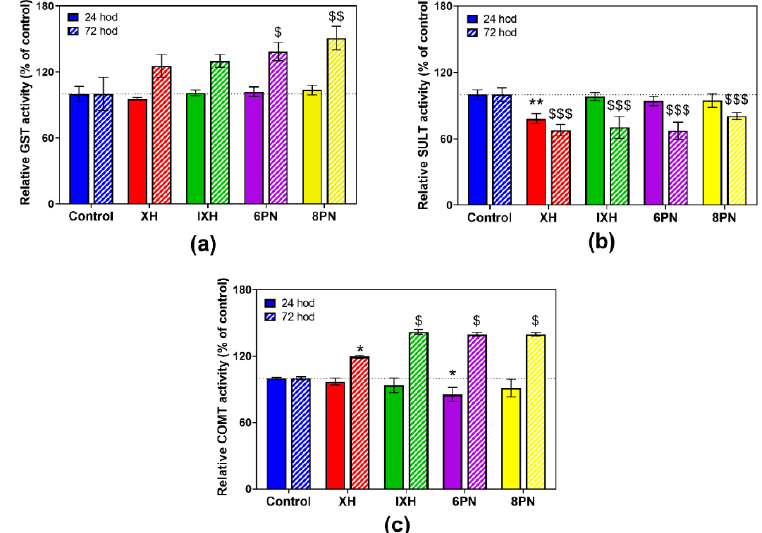
Figure 4. The effect of prenylflavonoids on the enzymatic activity of glutathione S-transferase ( a ), sulfotransferase ( b ) and catechol-O-methyltransferase ( c ) in the proliferating CaCo-2 cells after a 24 h and 72 h treatment with 1 µM of prenylflavonoid. The enzymatic activities were assayed using colorimetric assays. Data presented as percentage of the respective control (=100%) represent the mean ± S.D. of 3 – 4 independent experiments. Statistical analyses were performed using a one-way ANOVA with Dunnett ’ s test: p < 0.05 (*), p < 0.001 (§§§); * different from control after 24 h, $ different from control after 72 h.